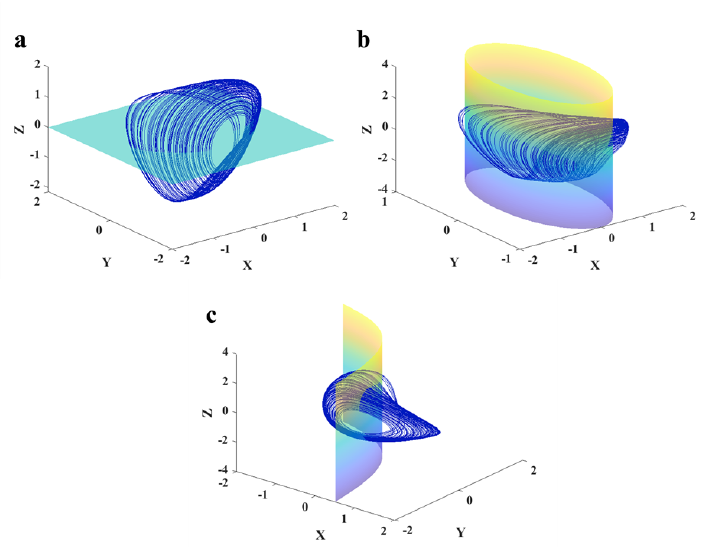
Figure 4. 3D chaotic dynamics of Equation (1) and the three pre-located manifolds ( a – c